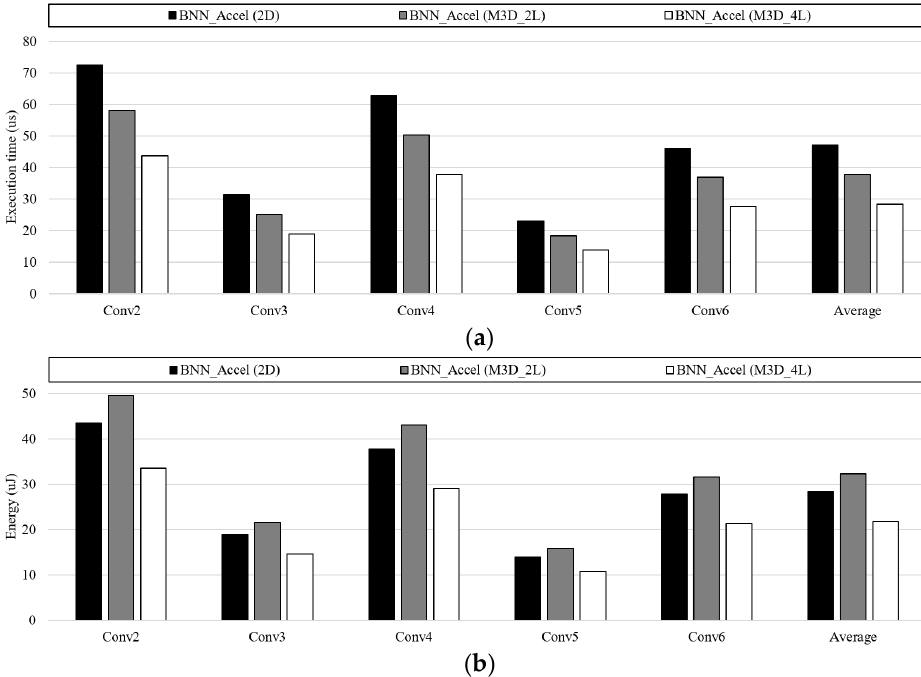
Figure 7. Execution time and energy consumption of three different BNN_Accels across the binarized convolution layers (i.e., Conv) ( a ) execution time results; ( b ) energy results. Table 3. Normalized results of BNN_Accel s in terms of execution time, energy and area. BNN_Accel (2D) BNN_Accel (M3D_2L) BNN_Accel (M3D_4L) Exec. time